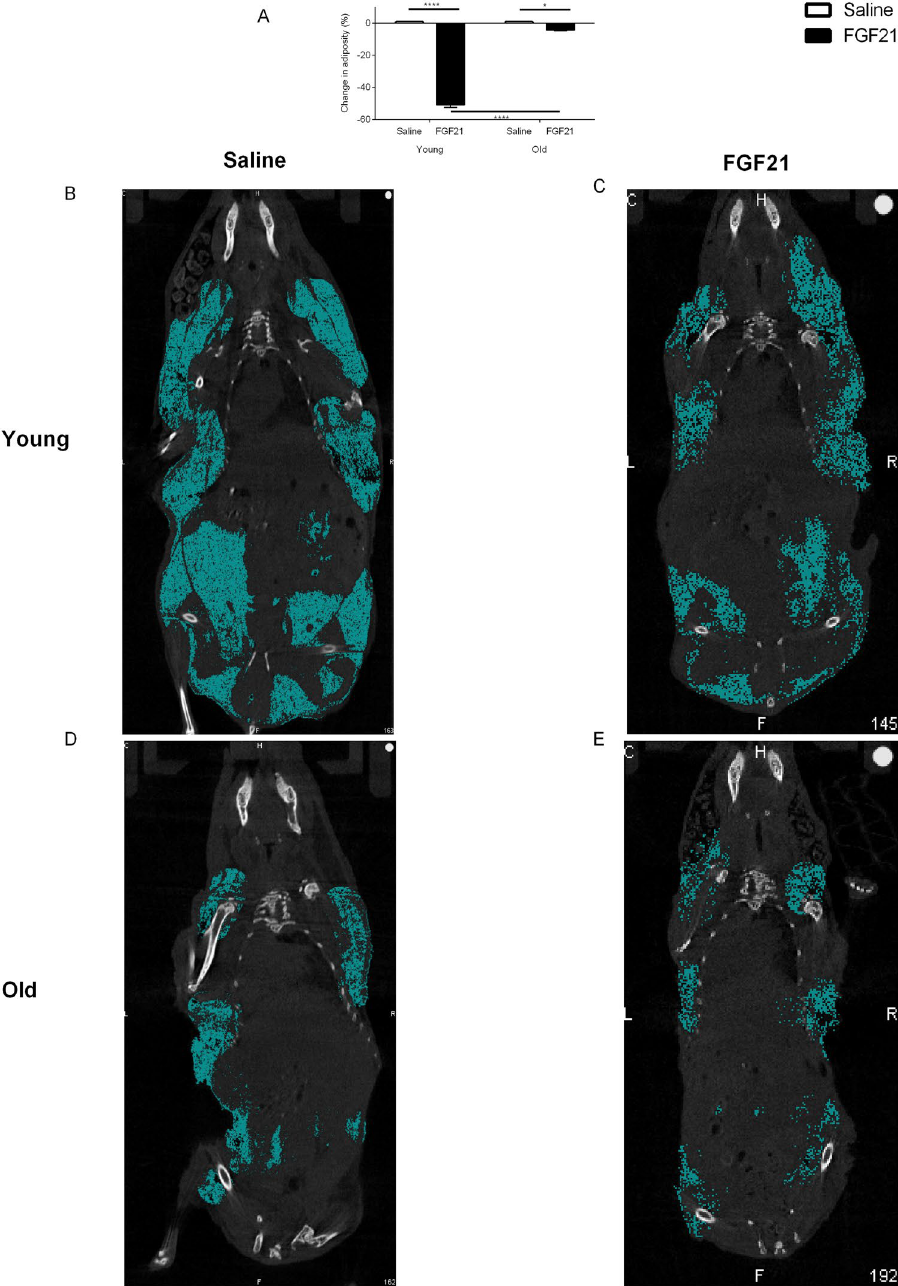
Figure 2. CT assessment demonstrates FGF21 reduces total adiposity in young and aged Siberian hamsters. Percentage change in total adiposity ( A ). Values are group mean ± SEM, n = 5–6 per treatment: * p < 0.05, ** p < 0.01, **** p < 0.0001. Representative images of young ( B and C ) and aged ( D and E ) Siberian hamsters treated with vehicle (saline) or FGF21